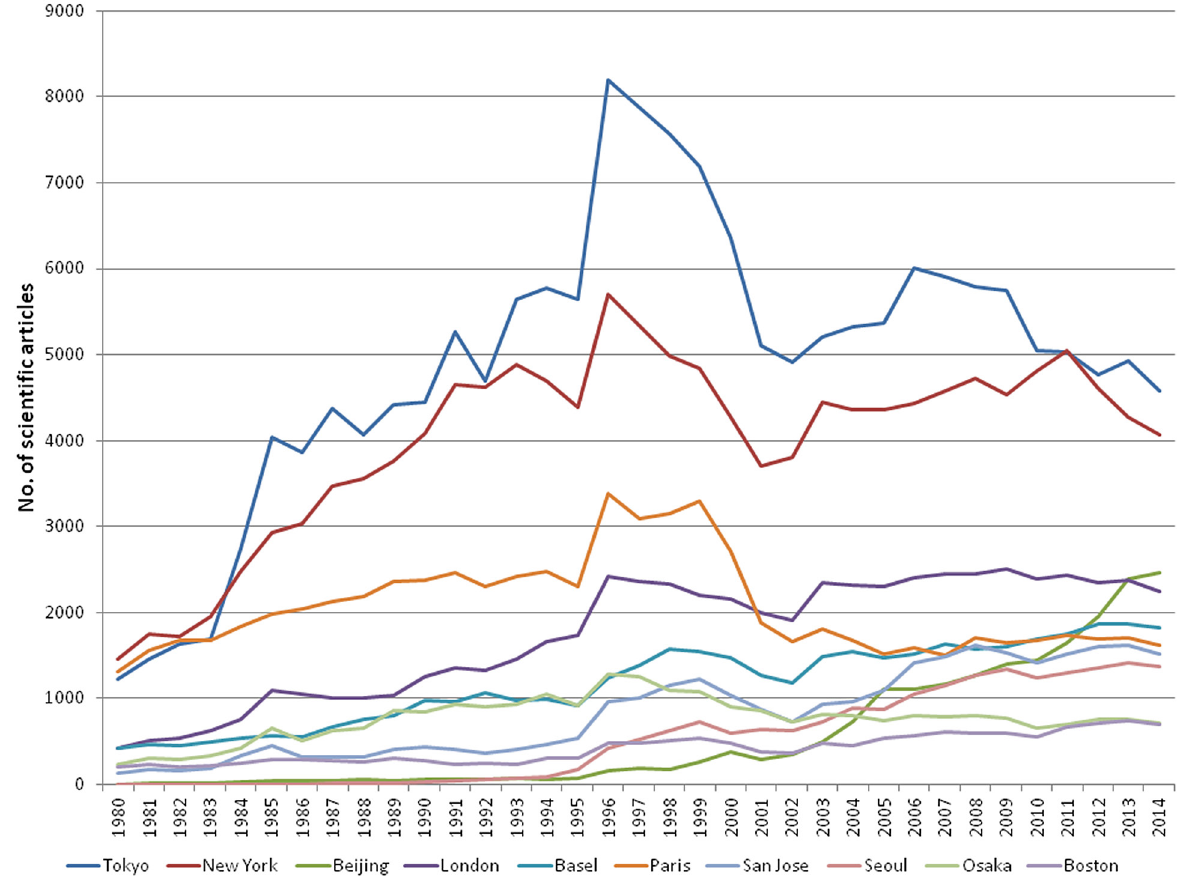
Fig. 2. Annual output of scientific articles by leading firms in Top 10 cities